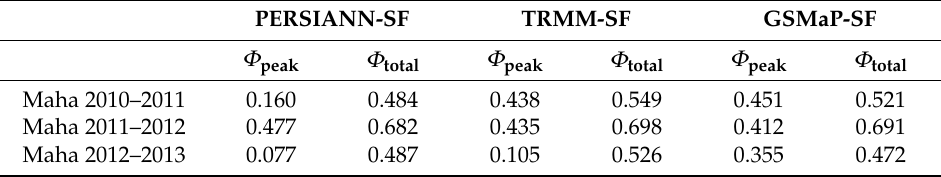
Table 8. Coincidence of inundation extent for the peak flooding times and the entire flooding periods. Values of the intersection ( A a ∩ A b ) and the union ( A a ∪ A b ) of domains of flood inundation were calculated by the SREs and Gauged-R and their rate ( Φ ) for peak flooding times in the Maha 2010– 2011 season.